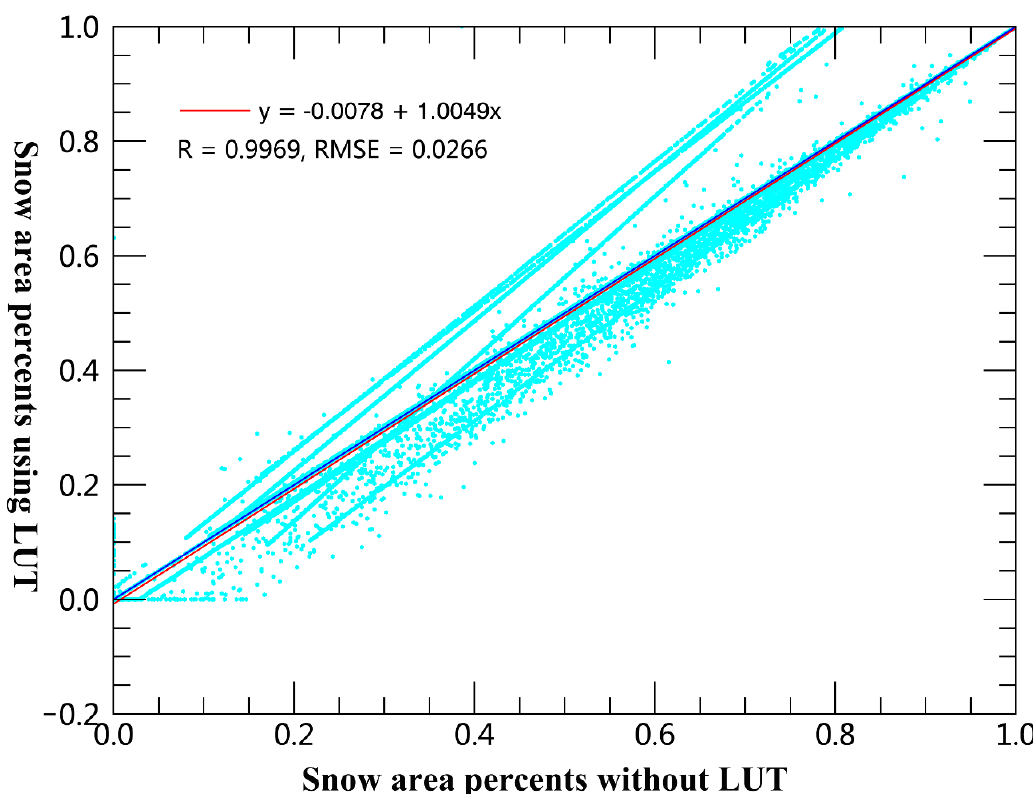
Figure 13. The comparison of the mapping results using LUT (look-up table) vs. without using LUT (1).